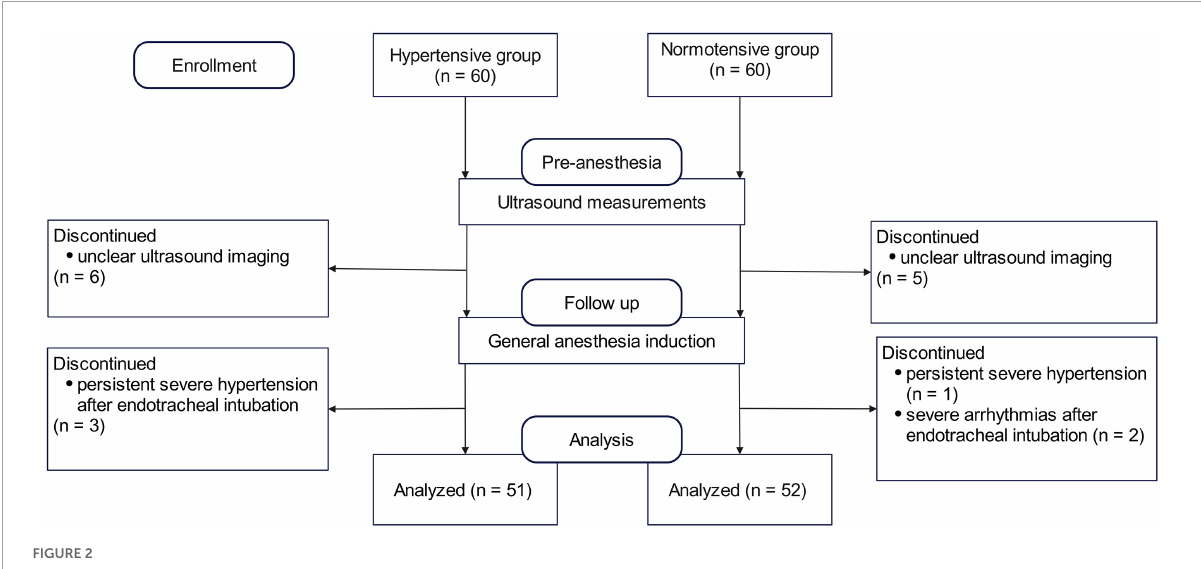
FIGURE2 Flowchart of the hypertensive and normotensive group.